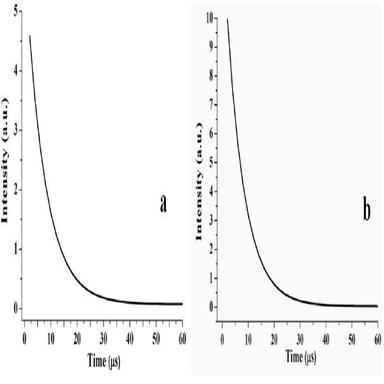
The decay curves of (a) Yb1.98Lu0.02Sn2O7 (b) Yb1.90Eu0.10Sn2O7.